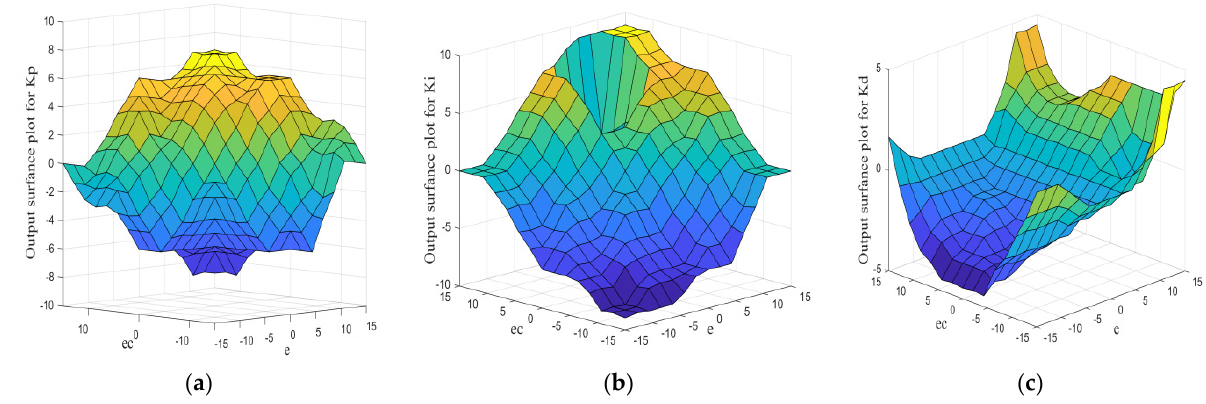
Figure 9. The three-dimensional output surface of the fuzzy control output variables: ( a ) K p output surface, input variables e and ec ; ( b ) K i output surface, input variables e and ec ; ( c ) K d output surface, input variables e and ec .